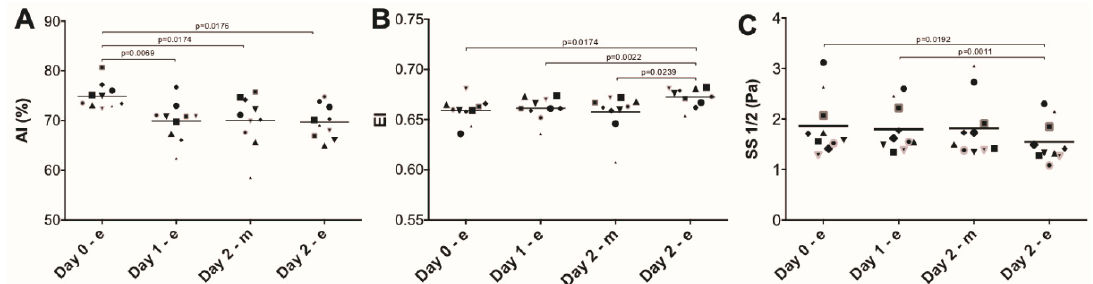
Figure 5. Red blood cell deformability and aggregation during the Nijmegen Four Days Marches. The tendency to aggregate (Aggregation Index, AI in panel ( A ); ANOVA main effect p = 0.0043), maximal deformability (Elongation Index, EI in panel ( B ); ANOVA main effect p = 0.0027), and the elongation kinetics during increased stress (SS ½ in panel ( C ); ANOVA main effect p = 0.0022) were measured using an LORRCA ektacytometer as described in Materials and Methods. Post-test significant differences (N = 10).